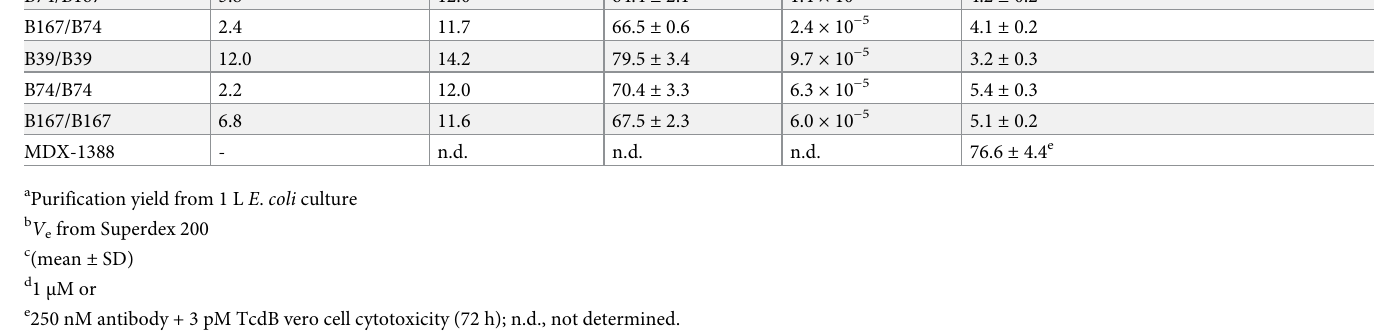
effects from combinations of V H-Fcs on TcdB inhibition, pairs of V H-Fcs (125 nM + 125 H H nM) were examined in neutralization assays ( S2 Table, Fig 5A and 5B ). The V H-Fc pair of H B94-hFc + B167-hFc achieved a maximum TcdB inhibition of 76.2%, slightly exceeding the neutralization potency of each V H-Fc alone and that of MDX-1388. In pairs containing H B39-Fc, the non-neutralizing antibody, overall neutralization was reduced by approximately 50% of the maximum inhibiting potency of the second antibody partner, reflecting the fact that 50% less inhibitory antibody was present ( Fig 5A and 5B ).